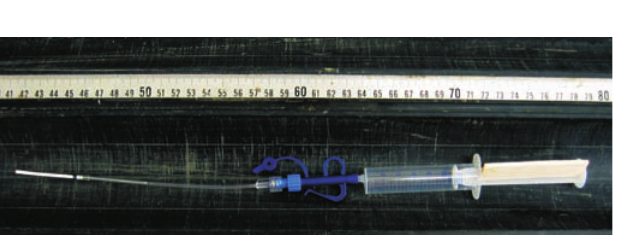
Figure 1. A Rhizon MOM 5-cm soil sampler with tube connector and syringe propped open with a wooden